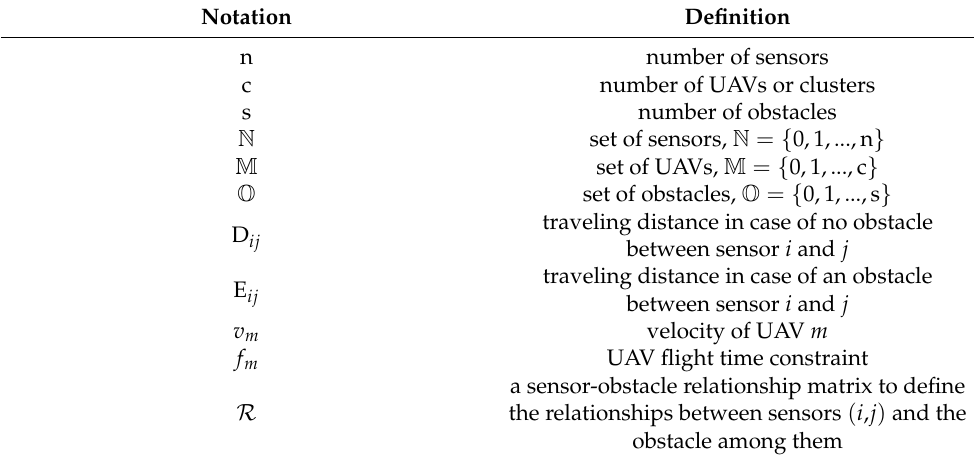
Table 1 lists the definitions for the rest of the symbols used in the problem formulation. Table 1. List of